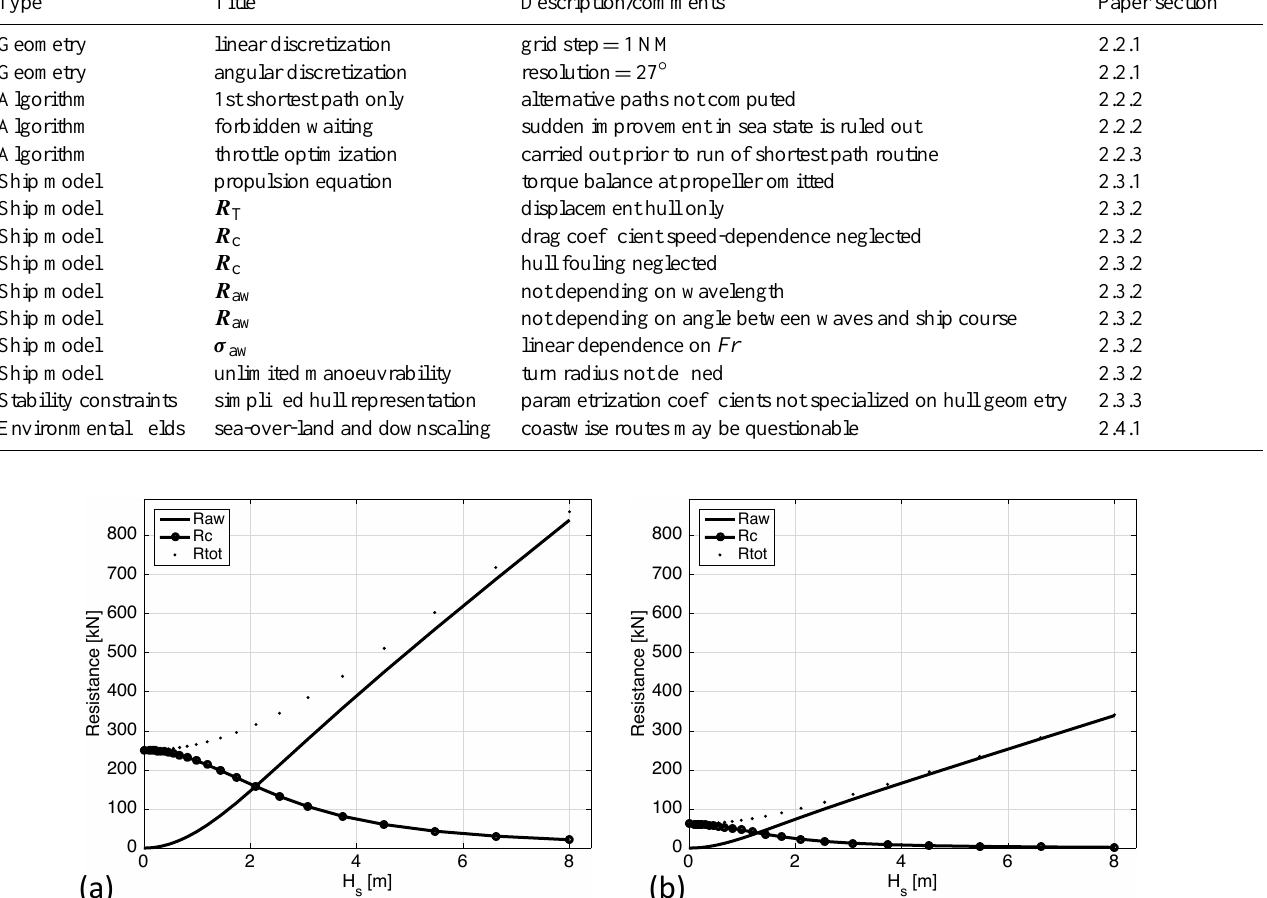
P max vs. significant wave height H s . Calm water R c , added =